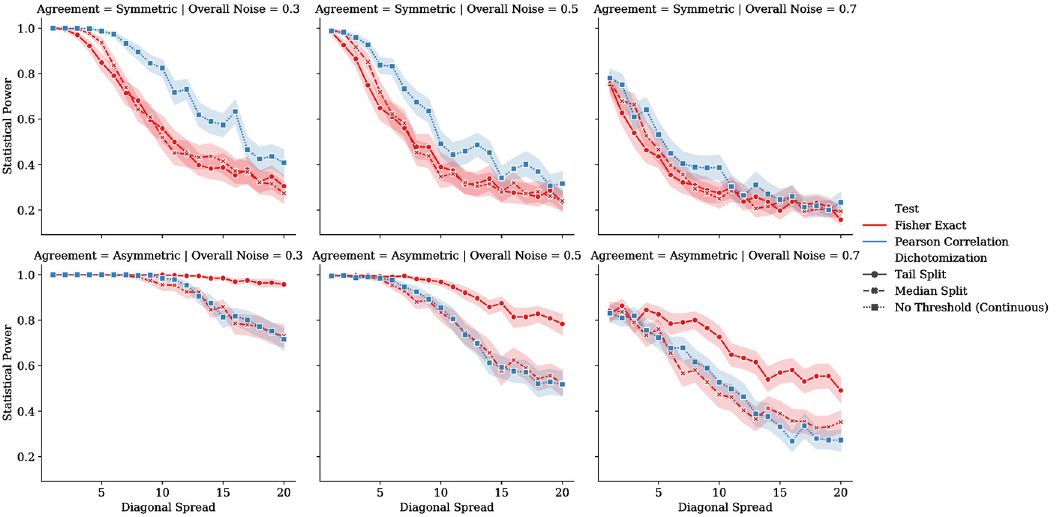
Fig 5. Statistical power achieved with the Pearson coefficient (a continuous measure of association; blue lines) and Fisher’s exact test (a measure of association between dichotomized variables; red lines) for synthetic data with symmetrical (upper row) and asymmetrical (lower row) properties with respect to agreement. Columns correspond to the level of uniform “overall” noise ( ω ) added to the data, representing prior uncertainty. X-axes represent the diagonal spread ( σ ), and the y-axes represent the test’s statistical power for the given sample size and estimated effect sizes. Data subjected to Fisher’s exact test were dichotomized at either a threshold of 5 (the “Median Split,” denoted by ‘+’ markers in red) or 3 (the “Tail Split,” denoted by the dot markers in red). For all series, dark lines denote means and the ribbons are 95% confidence intervals over 100